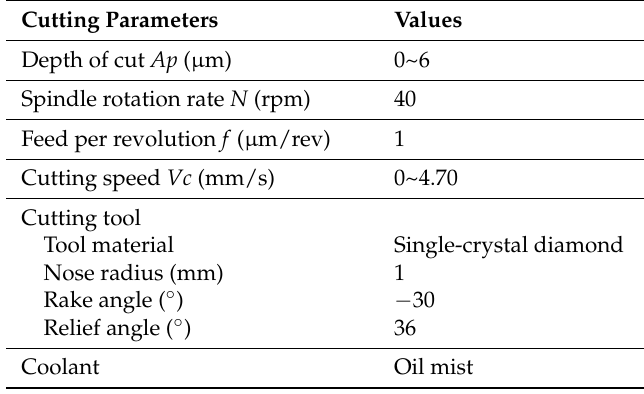
Table 3. Cutting conditions for a hexagonal microlens array of single-crystal silicon.